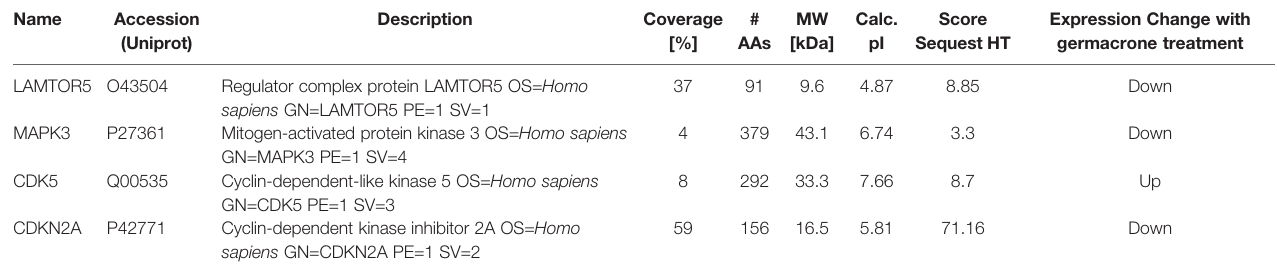
TABLE 1 | Details of four proteins related to the cell cycle, apoptosis, and